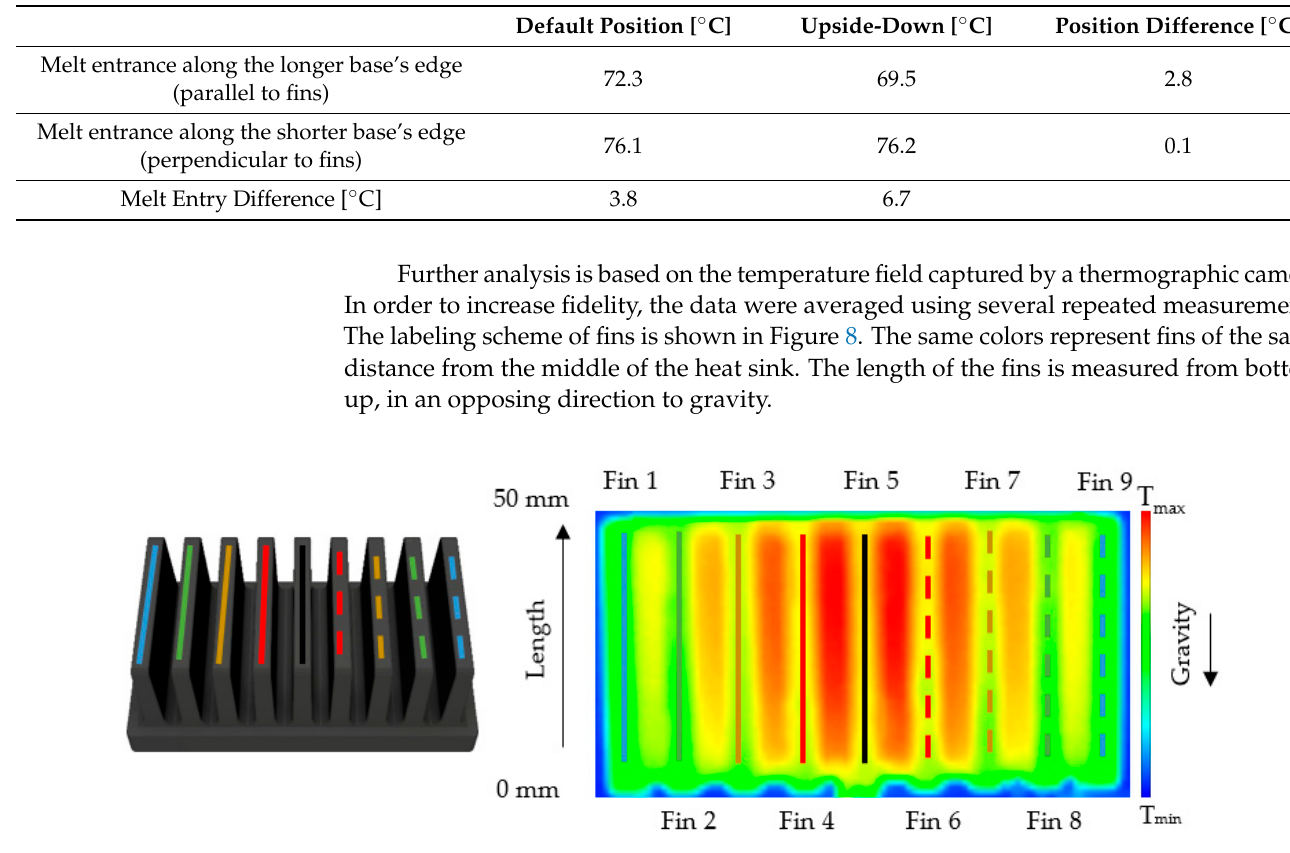
Table 1. Temperatures on the heater in all types of conducted measurements.